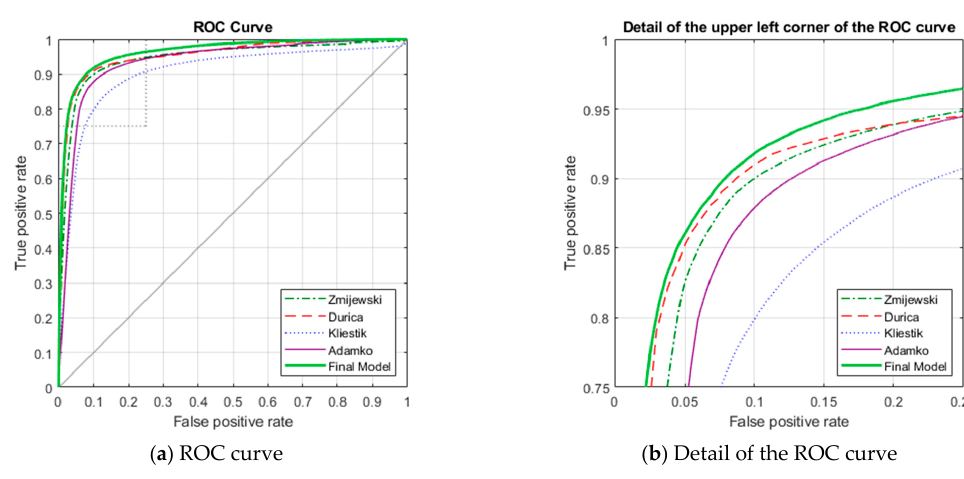
Figure 9. The comparison of ROC curves of the final model and other models. The final model is excellent to predict financial distress in the region. The Robust- Boost algorithm achieves better results than compared models. Therefore, it can be used as a stand-alone method to predict financial distress. Moreover, two other elements, namely CART and the k-NN method, achieve comparable results to the best models. Nev- ertheless, the k-NN method is the least useful to apply as a stand-alone method because its performance metrics were the lowest among the elements. The findings are based on research by Brozyna, Mentel and Pisula [37], Pisula [84], and Sivasankar et al. [82]. 6. Conclusions In the paper, we propose a prediction model for many sectors to estimate company failure in the Visegrad group countries using the ensemble model based on relevant fi- nancial variables from the Amadeus database by Bureau van Dijk/Moody’s Analytics [67]. The prediction model identifies in advance strengths and weaknesses in risk manage- ment. These results contribute to improving the stability, prosperity, and competitiveness in the region. Therefore, we are convinced that research on the prediction model is signif- icant for most stakeholders. The primary motivation is to decrease the direct and indirect cost of business bank- ruptcy using an ensemble model consisting of RobustBoost, CART, and k-NN. The method offers various kinds of benefits to business partners, bank institutions, investors, and politicians. We think that the ensemble model is an attractive technique to improve predictive accuracy. The results demonstrate that models achieve better predictive accu- racy than single models by Zmijewski [19], Kliestik, Vrbka, and Rowland [69], Adamko, Kliestik, and Kovacova [68], and Durica, Frnda, and Svabova [40] based on all provided performance metrics. The findings offer new knowledge to improve the performance of financial distress prediction in Central Europe. We identify several limitations of our study. Firstly, the model is relatively fast, es- pecially in comparison to ANN and SVM. However, the iteration process was demanding on computational time due to computer equipment. In addition, many calculations were conducted in the MATLAB cloud that also has its limitations. Secondly, the ensemble model is different from traditional methods, for example, discriminant analysis and lo- gistic regression, because we cannot explain the relationship among variables in the pre- diction model. This feature is a considerable disadvantage for many financial analysts, but we provided all the necessary settings to reconstruct the model. Finally, the limitation of